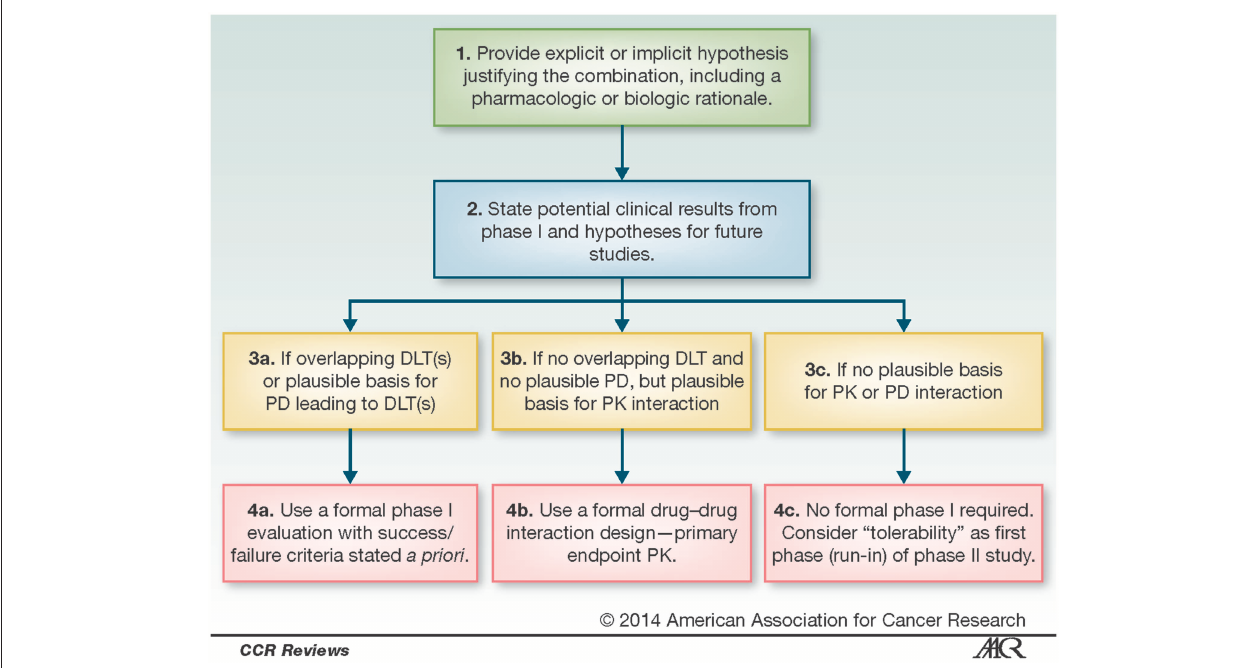
FIGURE 1 | Process for determining clinical trial design of phase 1 combinations. These recommendations for the design of phase 1 combination clinical trials, from the Clinical Trial Design Task Force of the NCI Investigational Drug Steering Committee, address expected overlapping dose-limiting toxicities (DLTs) or plausible pharmacokinetic (PK) and pharmacodynamic (PD) interactions, as well as rationale and potential clinical results. Reproduced from Paller et al. (10) no permissions